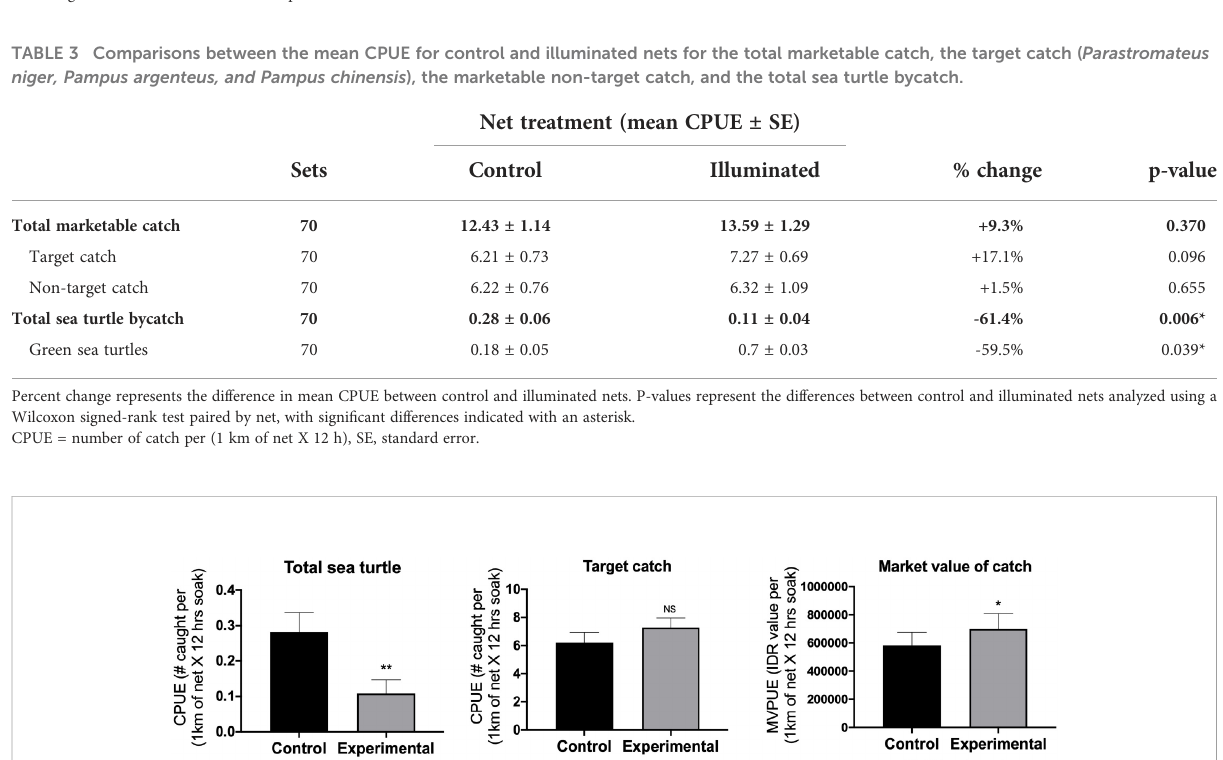
sets. For only 45 net pairs, the market data for both target and non-target catch was obtained. Analysis with the Wilcoxon matched-pairs signed-rank test showed that there was a signi fi cant (p-value = 0.023, Table 4) increase of 20.2% in the MVPUE of the total catch and a signi fi cant (p-value = 0.013, Table 4) increase of 15.0% in the target catch MVPUE when illuminated nets were used (Figure 2).